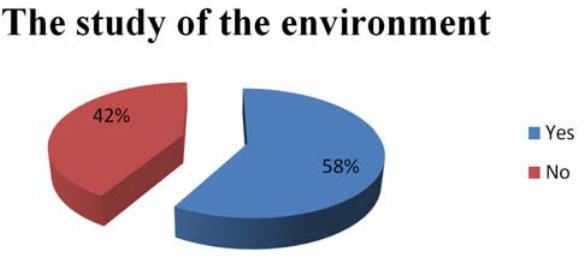
Fig. 2. The study of the environment